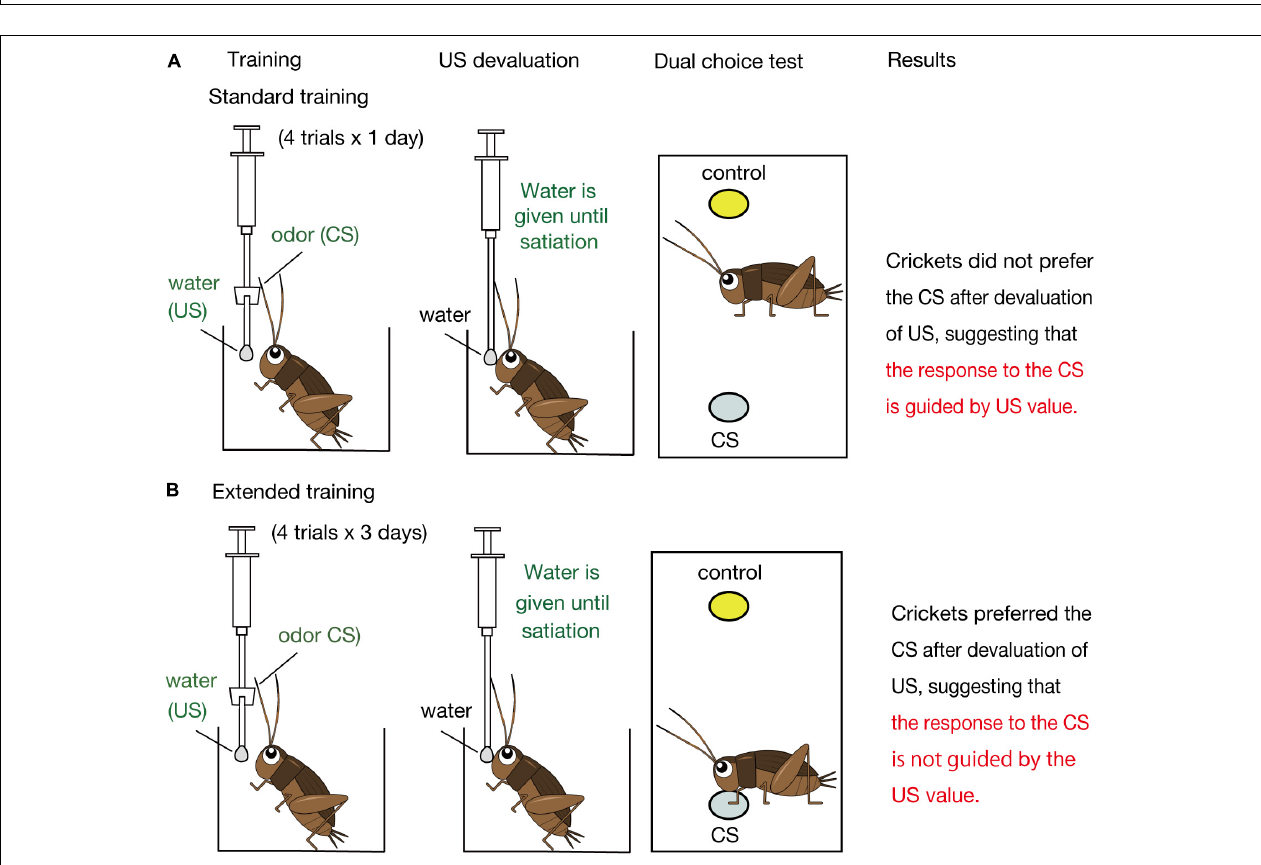
FIGURE 1 | Two possible versions of Pavlovian conditioning. In Pavlovian conditioning, neural connection or association may develop from the CS center to the US center or from the CS center directly to the response center. The former matches S-S association theory and the latter matches S-R association theory (Mazur, 2017). Pavlov’s stimulus substitution theory (Pavlov, 1927) can be considered as a form of the S-S learning theory.